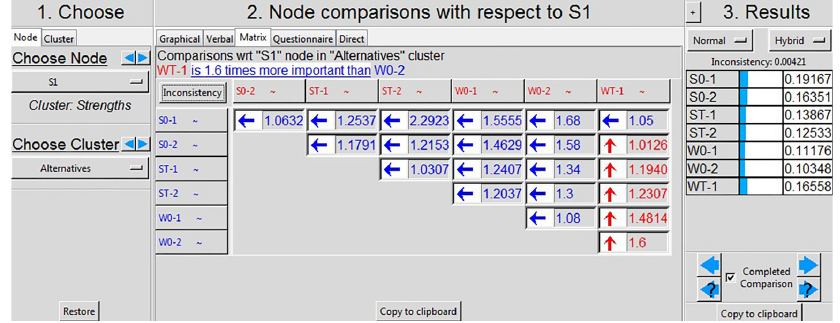
Fig. 6. The pairwise comparison matrix of alternatives based on S1